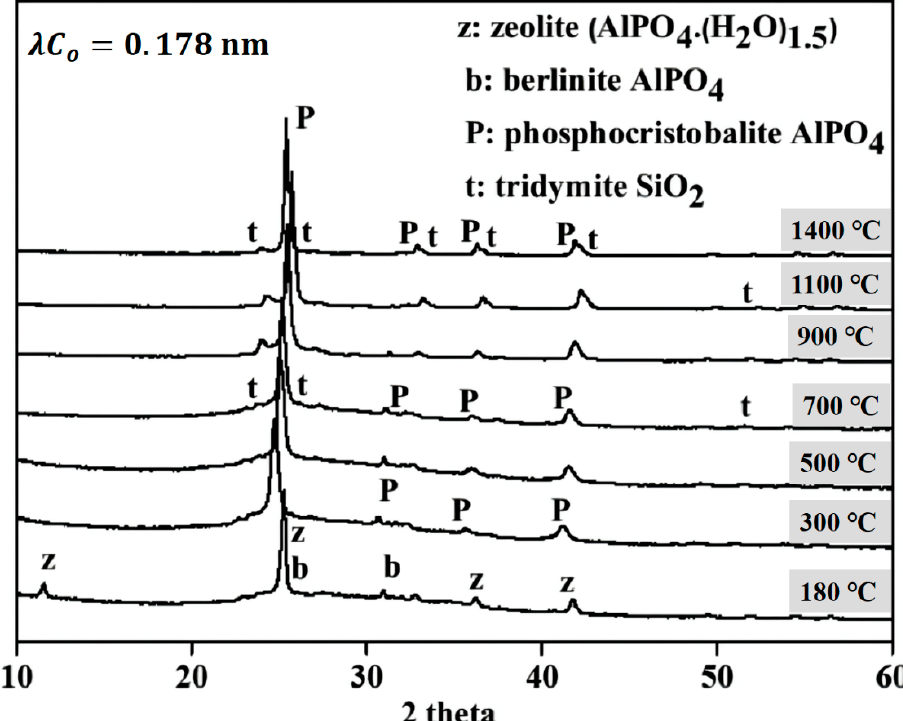
Figure 7. Phase evolution of geopolymer at elevated temperature [73].